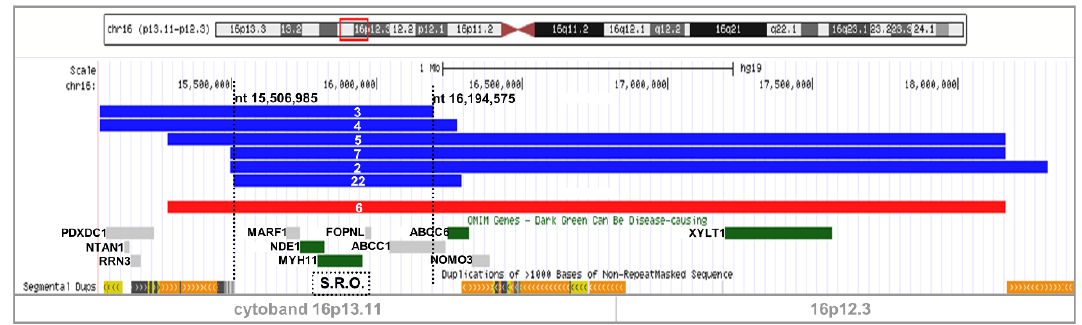
Figure 3. Smallest region of overlapping on 16p13.11. One bar corresponds to one patient and the number refers to the patients reported in Table 1. Red bar indicates a deletion, blue bar a duplication. OMIM genes and segmental duplications are reported.